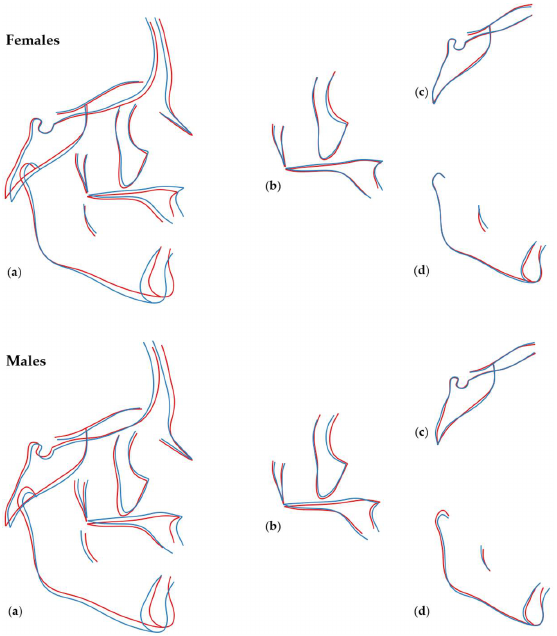
Figure 6. Regression of shape on number of missing teeth, not including third molars, in females (top row) and males (bottom row). The blue lines represent shape configurations in cases with no or few missing teeth (−4SD from average shape), and the red lines represent shape configurations in cases with large number of missing teeth (+4SD from average shape). The following shape configurations are displayed: ( a ) entire craniofacial configuration, ( b ) maxilla, ( c ) cranial base, ( d ) mandible. Cranial base differences were not statistically significant.